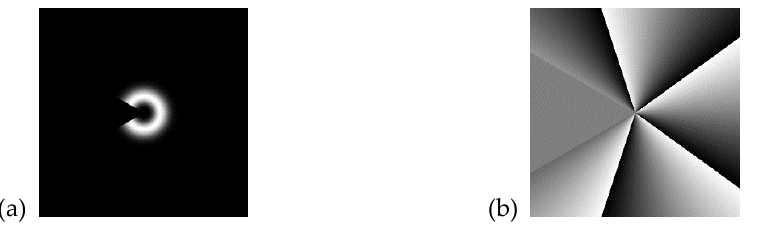
Figure 3. An amplitude ( a ) and phase ( b ) of the incident field at α = 150°, 20 × 20 μ m, TC m = 5.